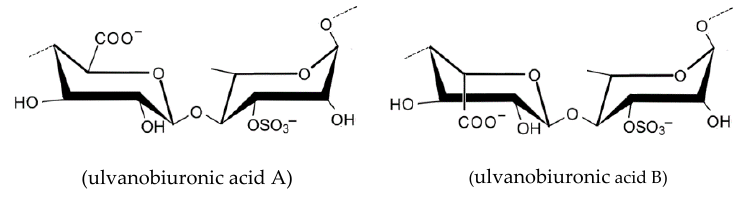
Figure 7. Idealized structure of ulvan chemical units.